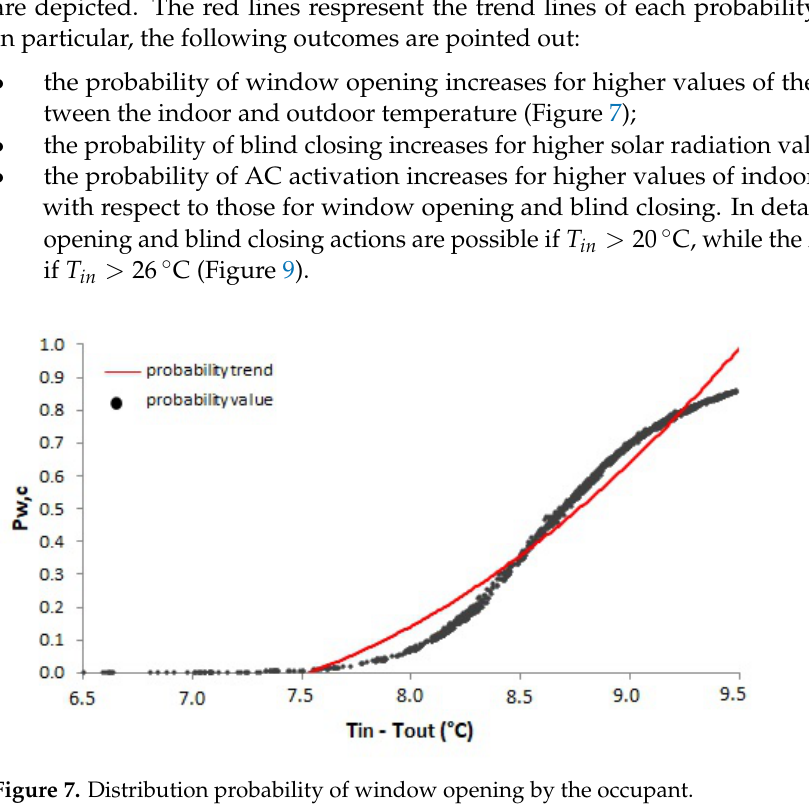
Figure 7. Distribution probability of window opening by the